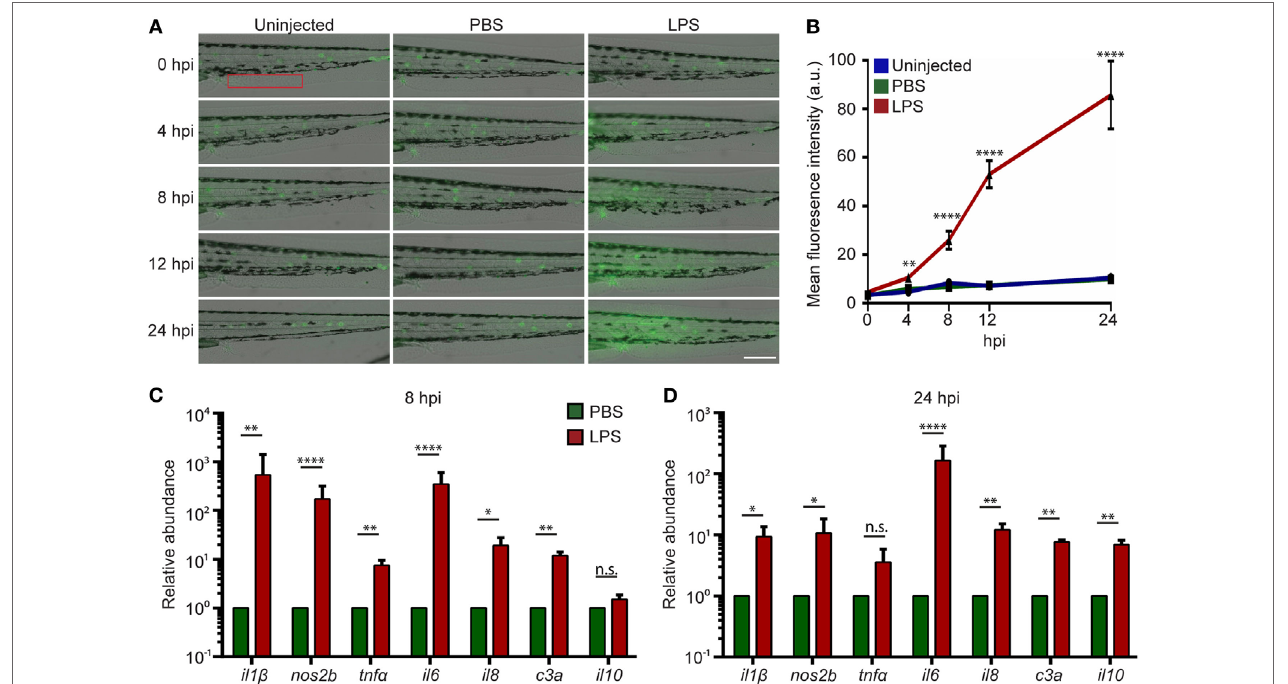
FigUre 2 | Intravenous (IV) lipopolysaccharide (LPS) activates NF- κ B pathway and elicits a systemic immune response. (a) Tg(NF: κ B:GFP) larvae were IV injected with PBS, LPS, or left uninjected. Representative images of GFP signals at indicated time points post injection. Images representative of three independent experiments were shown ( n = 20). Scale bar: 200 µm. (B) Quantification of the GFP intensity in the caudal fin region (red box in Figure 2a ). Results are presented as mean ± SD (D) ( n = 3 independent experiments with over 20 larvae each/experiment). ** p < 0.01, **** p < 0.0001, Kruskal–Wallis test. (c,D) Transcript levels of genes encoding pro-inflammatory and anti-inflammatory cytokines in whole larvae injected with either PBS or LPS at 8 hpi (c) and 24 hpi (D) . Results were normalized with ef1 α and are presented as means ± SD ( n = 3 biological repeats with 20 larvae in each group). * p < 0.05, ** p < 0.01, *** p < 0.001, **** p < 0.0001, Sidak’s multiple comparisons